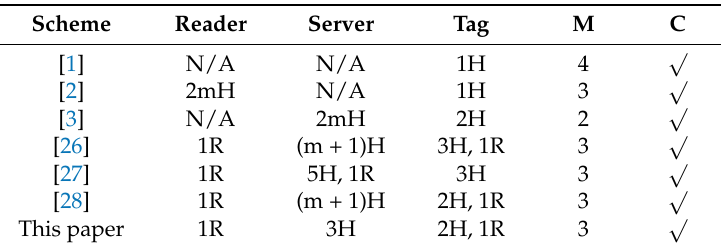
Table 3. Performance